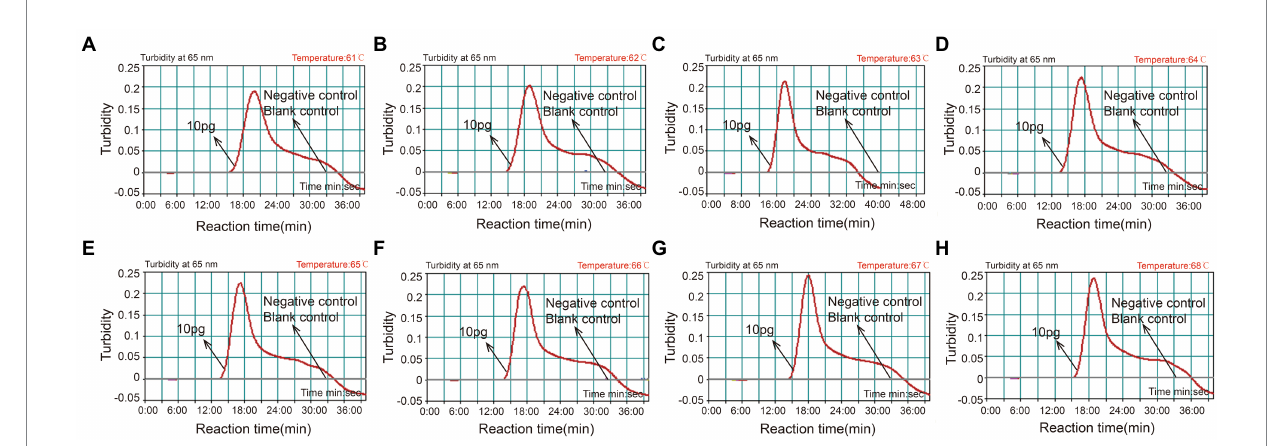
FIGURE 3 Optimal amplification temperature for CVA16-MCDA-LFB assay. By using a real-time measurement to monitor the turbidity of CVA16-MCDA-LFB reactions. The corresponding curves were displayed in the panels. The negative control was virus RNA of EVA71, and the blank control was sterile double-distilled water. Abscissa represents reaction time (min), ordinate represents turbidity. The threshold value was 0.1, and the turbidity >0.1 was considered as positive amplification. Eight kinetic curves (A-H) were generated from 61 to 68 ° C (1 ° C intervals), with 4 × 10 6 copies/ μ L of pUC57-CVA16- VP1 DNA per reaction.